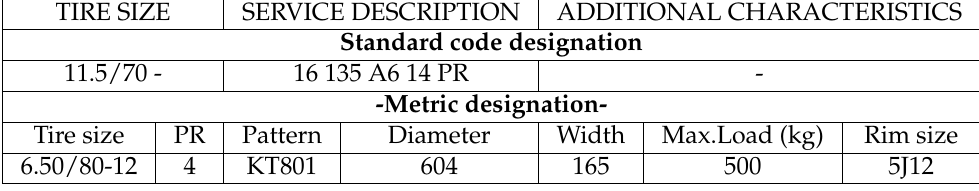
Table 1. Tyre measure and matching